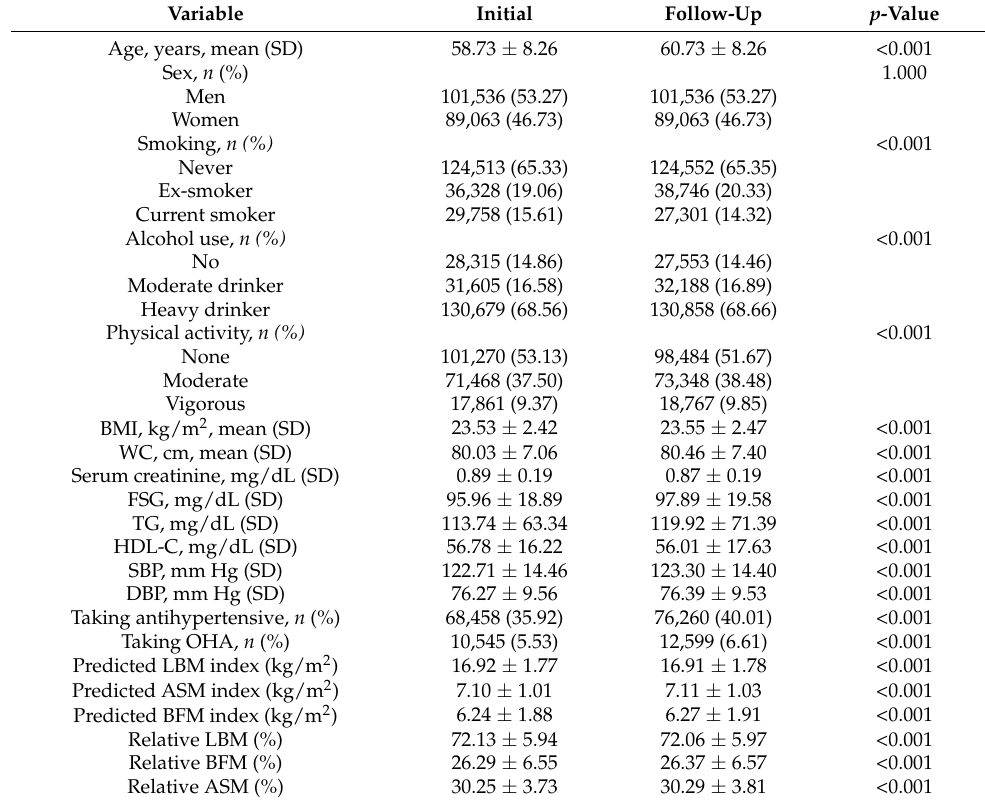
Table 1. Descriptive characteristics of the study participants ( n = 190,599).